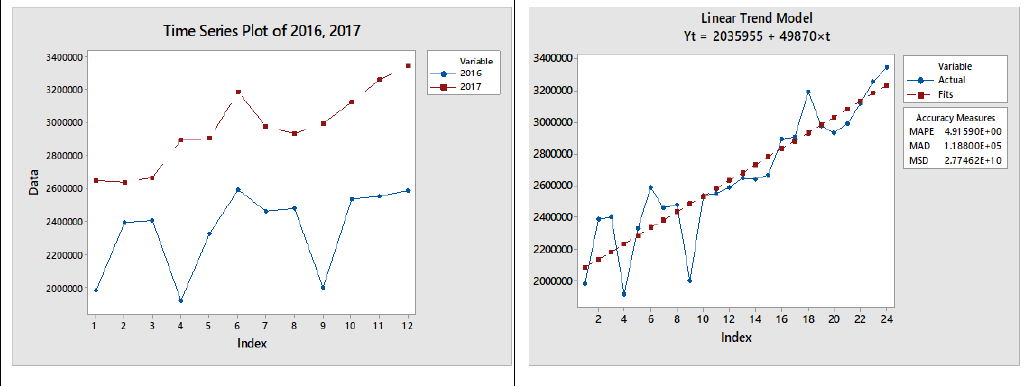
Fig. 5. Seasonal pattern and trend analysis for ISM.